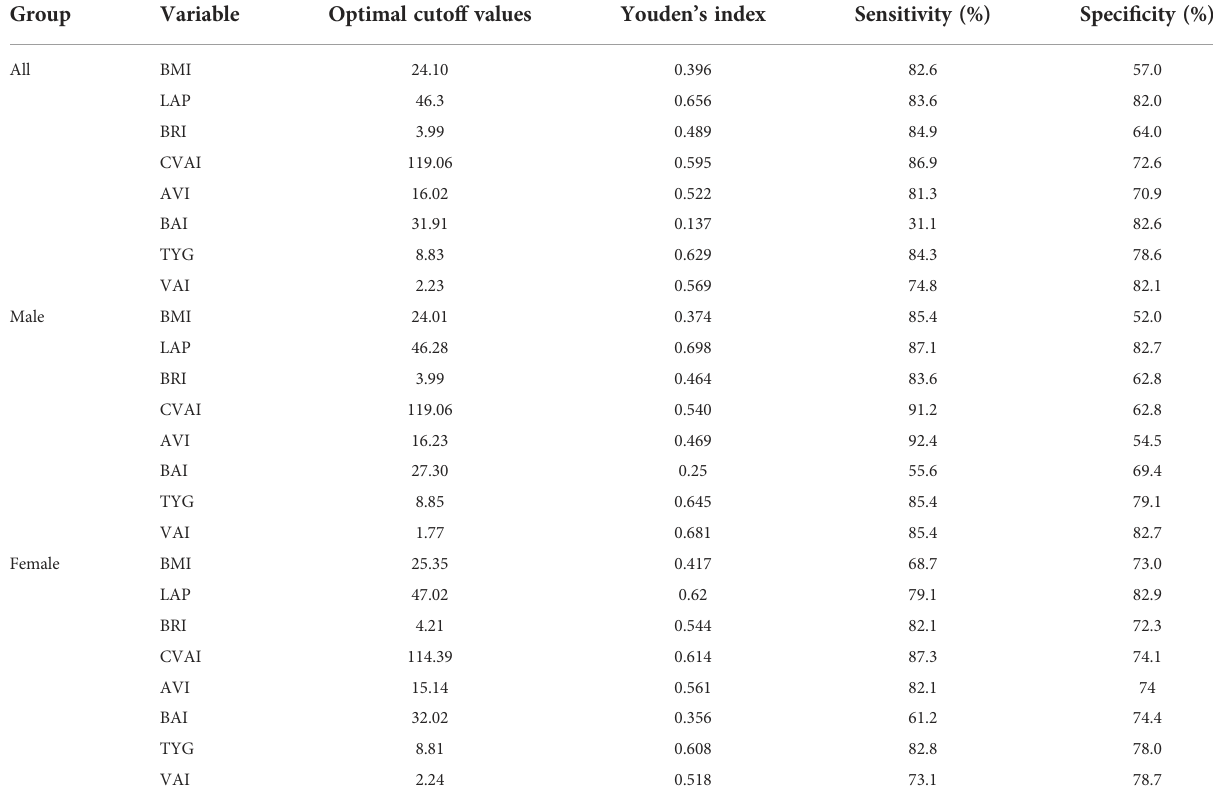
TABLE 6 The cutoff, sensitivities, speci fi cities, and Youden ’ s index of each variable for the screening of metabolic syndrome in the China (2020) criteria. Group